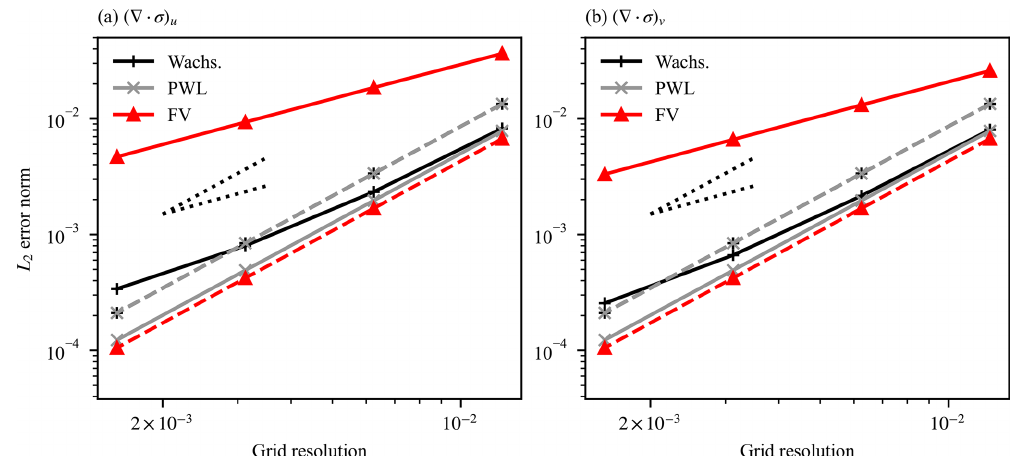
Figure 6. Scaling of L 2 error norm against grid resolution for the model calculation of the (a) u and (b) v components of stress divergence from an analytical strain rate tensor field for a planar test case with a regular mesh. Grid resolution is the mean distance between cell centers. Solid lines denote hexagonal cell meshes, whereas dashed lines signify square cell meshes. Ideal first- and second-order scaling gradients are also shown as dotted